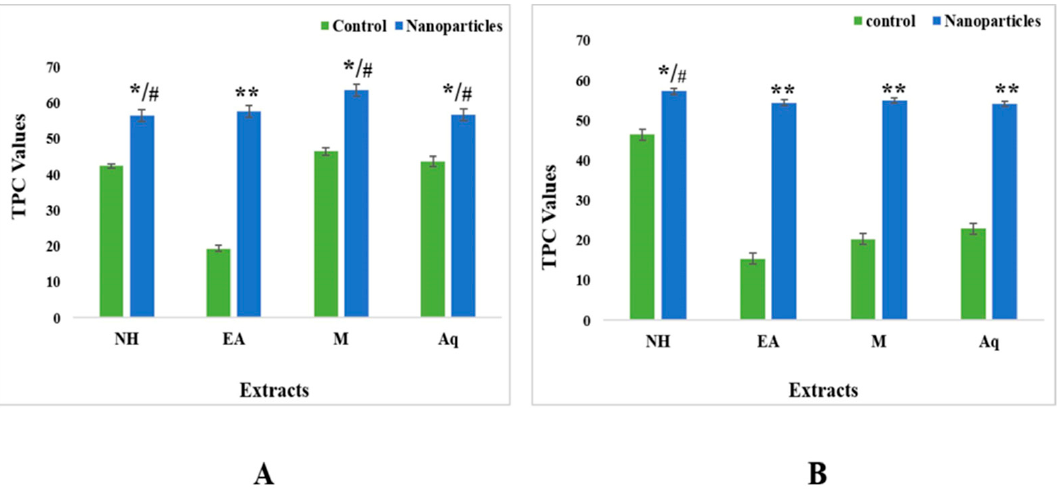
Figure 7. Total phenolic contents of control and nanoparticles from ( A ) leaf and ( B ) fruit extracts of C. colocynthis . Mean ± SD is expressed as */# p < 0.05, ** p < 0.01.